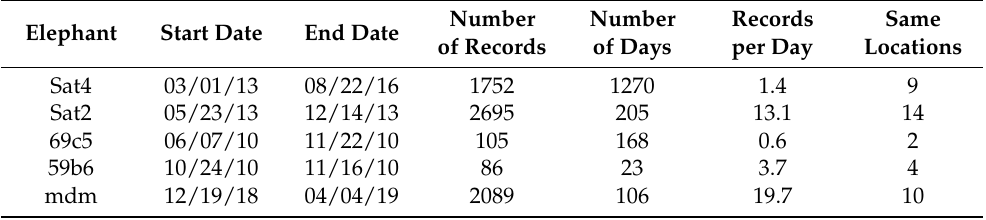
Table A1. Comparison of resistance model correlation with genetic